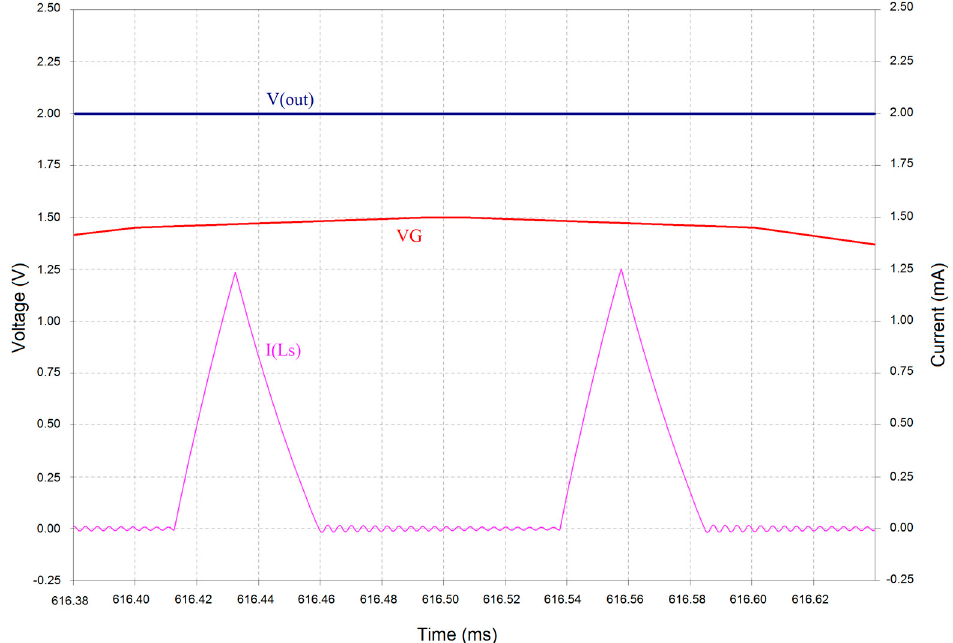
Figure 14. A detail of the charge–discharge cycle of the inductance. The blue line reprents the output voltage stored on the supercap; the red waveform is the input voltage, while the pink line is the current floing the the inductance Ls . The values correspond with a good approximation to those reported in the text. The small ringing at the bottom of the current waveform corresponds to a residual oscillation of the inductance with the parasitc capacitance of the diode and starts as soon as the current charging the capacitors vanishes.